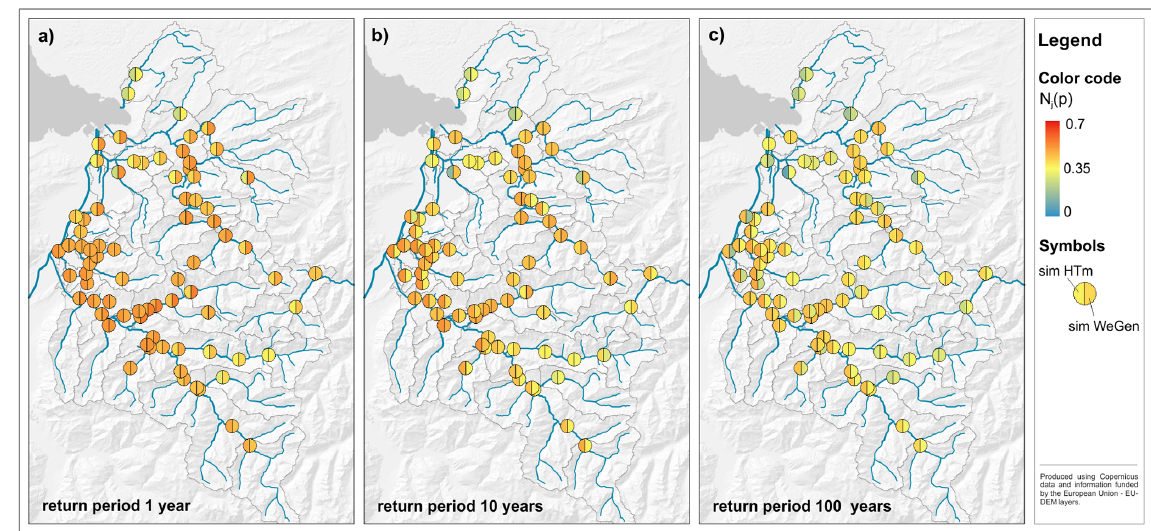
Figure 5. Spatial dependence measure N j (p) for the community node points at the river network and three different return periods. The results show the median for the HT-model and WeGen approach based on 30 realisations of 1000 years of simulation.